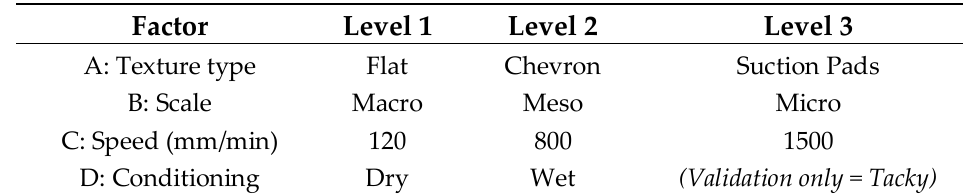
Table 1. Mixed-level fractional factorial design table comprising three 3-level design factors (A, B, C) and one 2-level design factor (D).